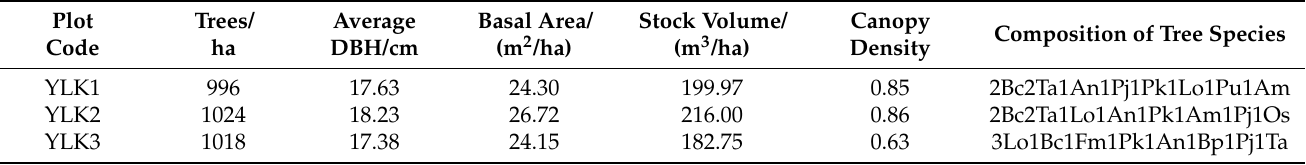
Table 1. Stand characteristics of 3 plots in